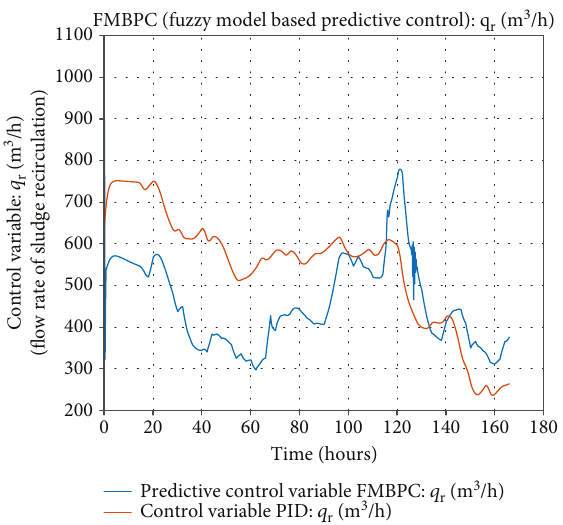
Figure 25: E ffl uent substrate by FMBPC and PID (case D).